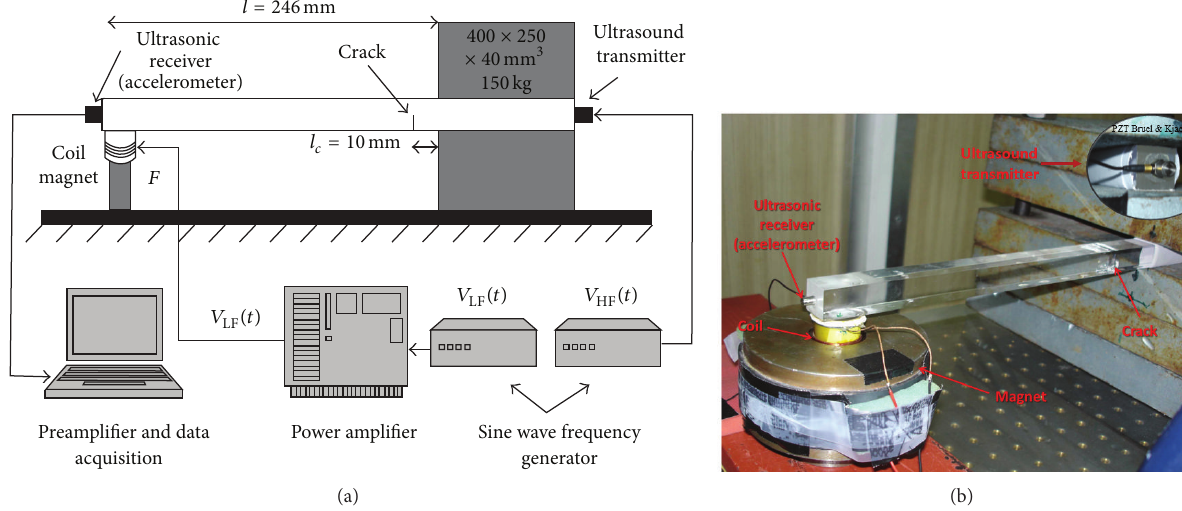
Figure 1: A schematic representation (a) and the actual realization (b) of the experimental setup.